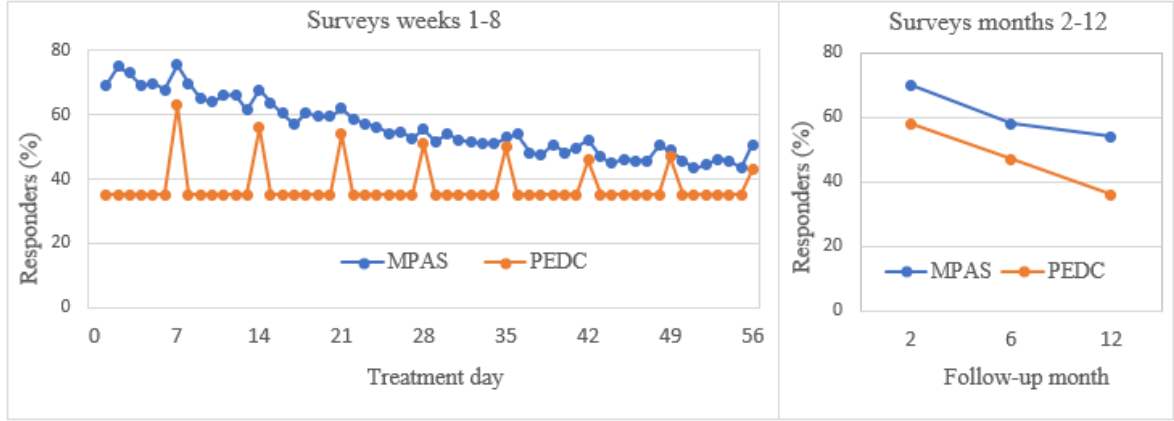
Figure 2. Effectiveness of data collection between the mobile phone automated system and the paper and email data collection. MPAS: mobile phone automated system; PEDC: paper and email data collection.